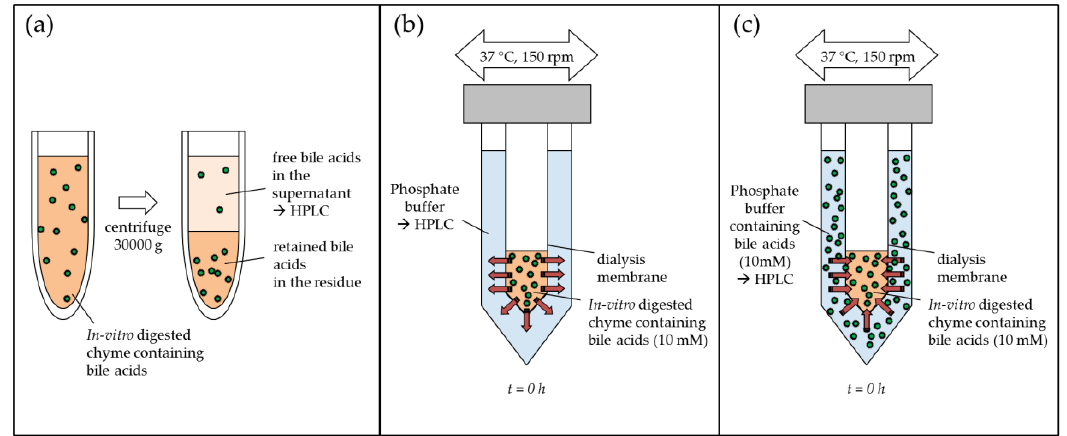
Figure 5. In vitro model approaches for simulation of bile acid reabsorption: ( a ) centrifugation method (Section 4.5.2), ( b ) bile acid release from simulated chyme using dialysis (Section 4.5.3), and ( c ) inverse dialysis model for the determination of adsorptive effects (Section 4.6).